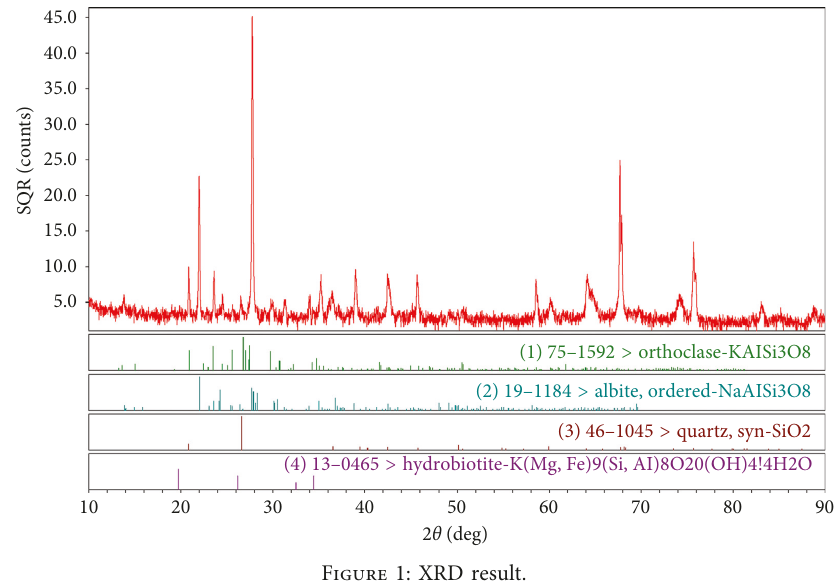
Figure 1: XRD result.